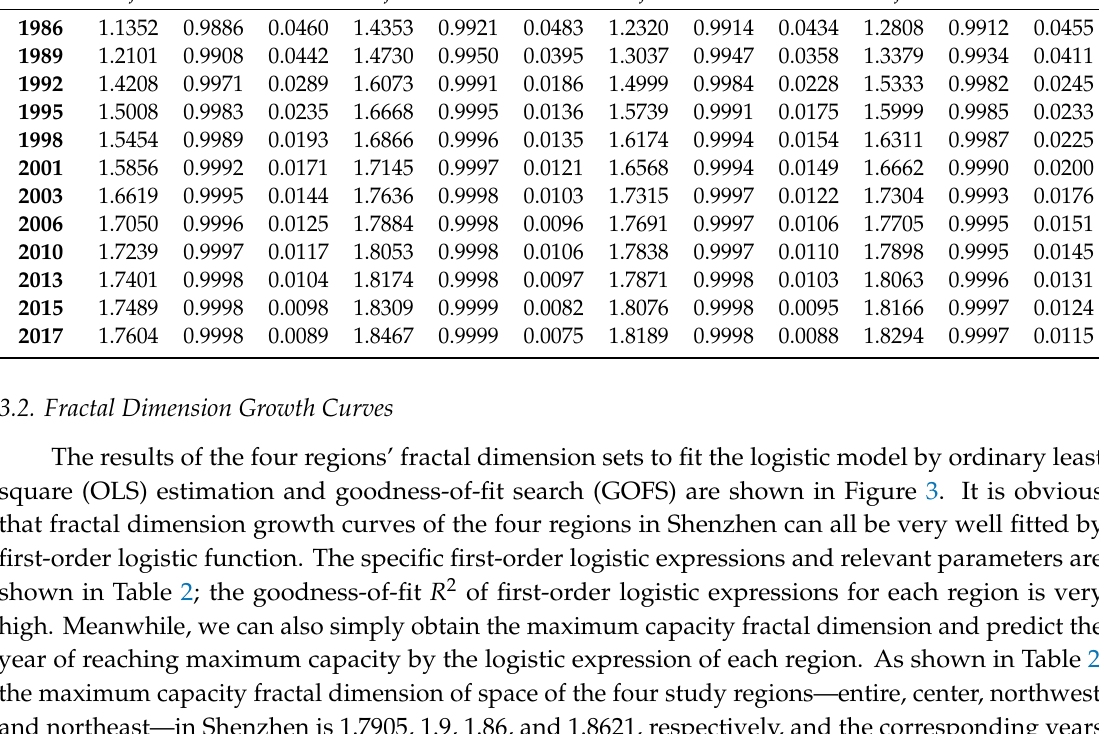
Table 1. Fractal dimension estimates of the urban form of four regions in Shenzhen, 1986–2017. Entire Region Center Region Northwest Region Northeast Region Year D f R 2 σ D f R 2 σ D f R 2 σ D f R 2 σ